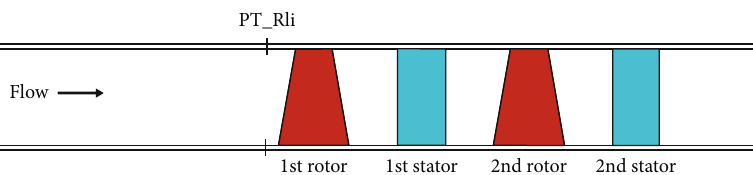
Figure 3: Sensor arrangement sketch of the low-speed axial compressor.